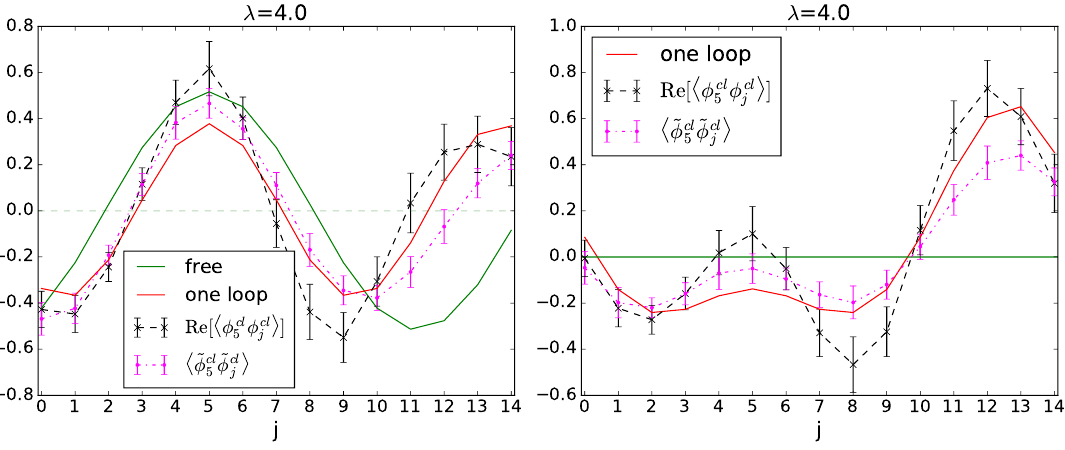
Figure 7 . On the left, the full quantum correlators (cl-cl) for a free and interacting theory at (cid:21) = 4. On the right, when subtracting the free